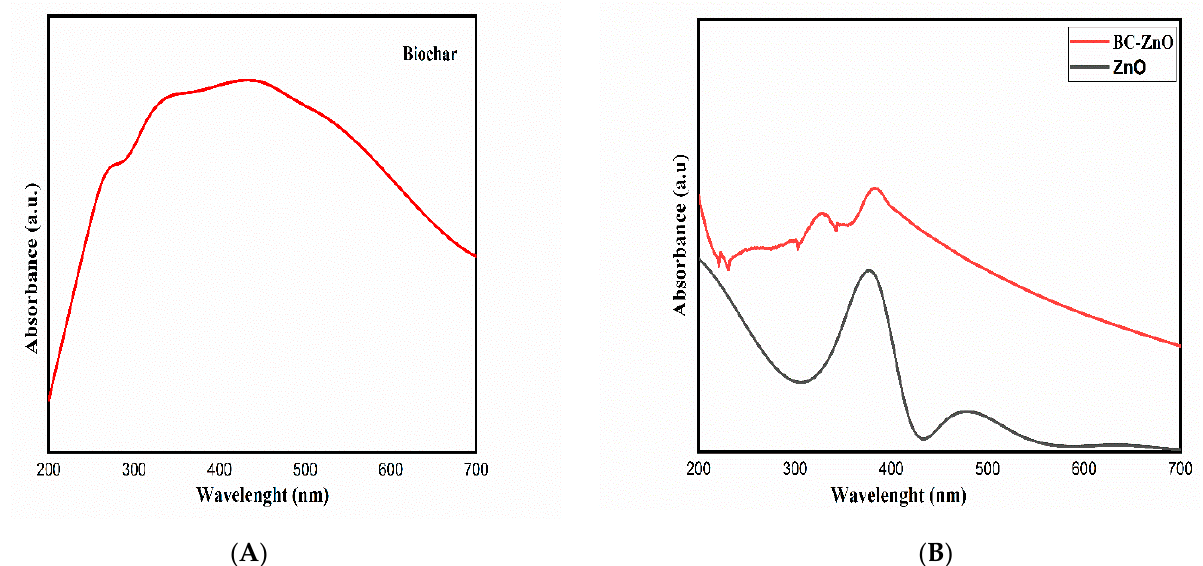
Figure 6. UV analysis of pure biochar ( A ), pure ZnO, and MB-ZnO ( B